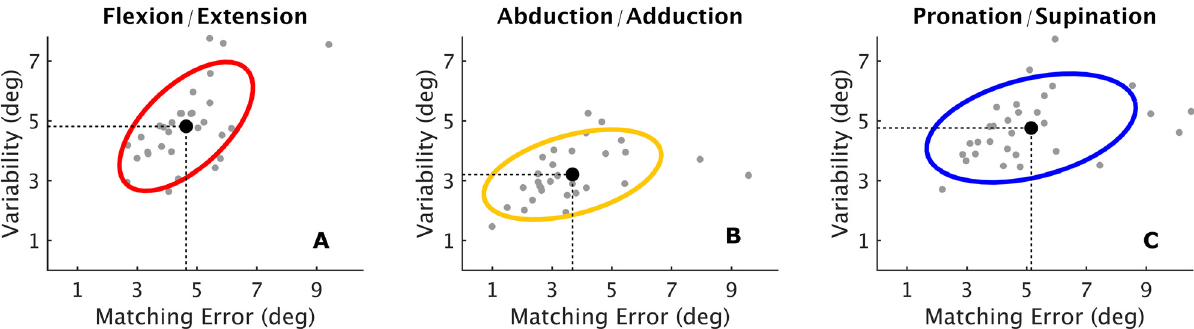
Fig 2. Matching error and variability for flexion/extension (A), abduction/adduction (B) and pronation/supination (C). The AA results the most accurate DoF (smallest matching error ) and the most precise (lowest variability ), compared with the other two (black dots). The three ellipses indicate the region that contains 75% of all samples (grey dots), obtained by averaging the 12 active trials for each subject (in total 30 grey dots represented in the figure for each Dof). The ellipses are obtained from the covariance matrix of the sampled data, where the eigenvectors of the covariance matrix represent the axes of the confidence ellipse, and thus models how the data was rotated. The eigenvalues on the other hand represent the variance of the data in the direction of these axes.